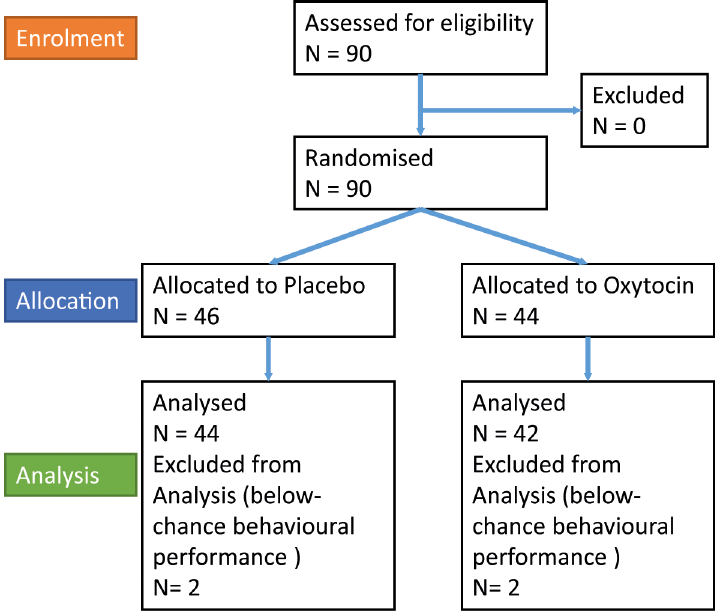
Fig 1. CONSORT flow diagram. Flow diagram of the progress through the phases of a parallel randomised trial of two groups [66].